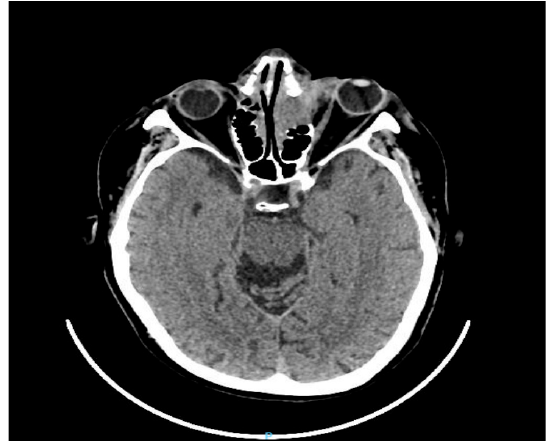
Figure 3. Computed tomography of the brain and orbit (axial planes) showed a front-ethmoid tissue mass with bone destruction and regional invasion with the left orbital extension in contact with the eyeball and left frontal intracranial extension of approximately 3.8/4/4.2 cm. The patient’s treatment began with maximal topical anti-glaucoma eye drops (topical beta-blockers, alpha-agonists, and carbonic anhydrase inhibitors). The patient’s care was subsequently co-managed with the oncological team. He started radiotherapy sessions according to the Intensity Modulated Radiation Therapy (IMRT)) scheme with a total dose of 30 Gy in 15 fractions given in 3 weeks and 2Gy/fraction. The irradiation was done with a thermoplastic mask after a CT planning where the tumor mass and adjacent structures were contoured (red color). Radiation doses delivered to normal anatomical structures (optic nerves, the lens) were within parameters (Figure